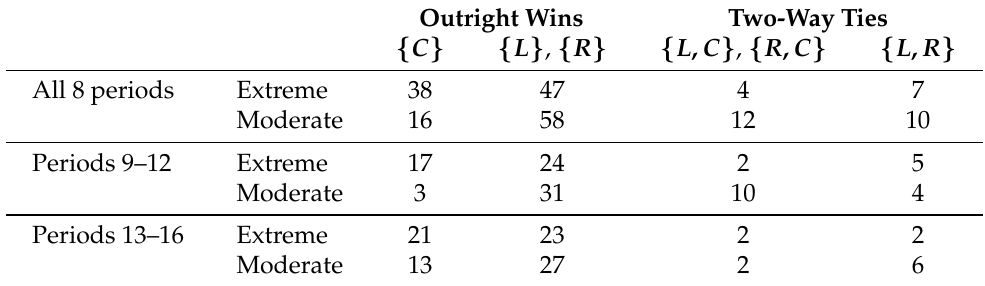
Table 3. Composition of the winning